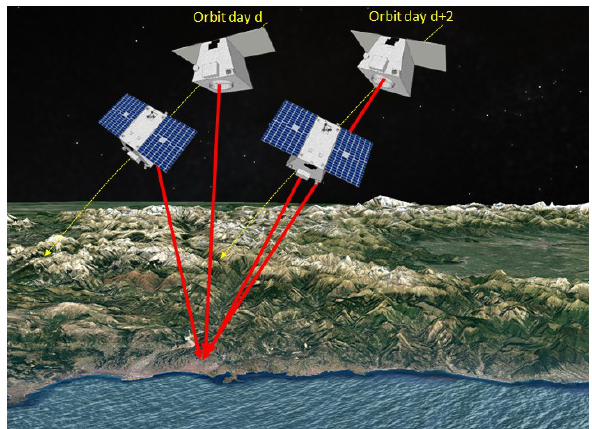
Figure 6. CO3D ‘Diamond’ geometry acquisitions